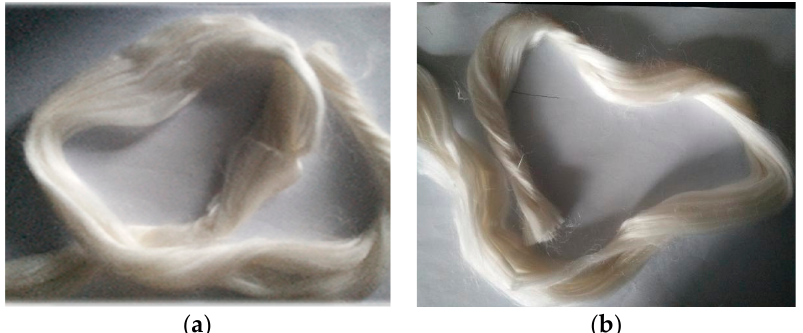
Figure 1. The apparent morphology of pineapple leaf fiber (PALF) ( a ) and ramie fiber (RF) ( b ).